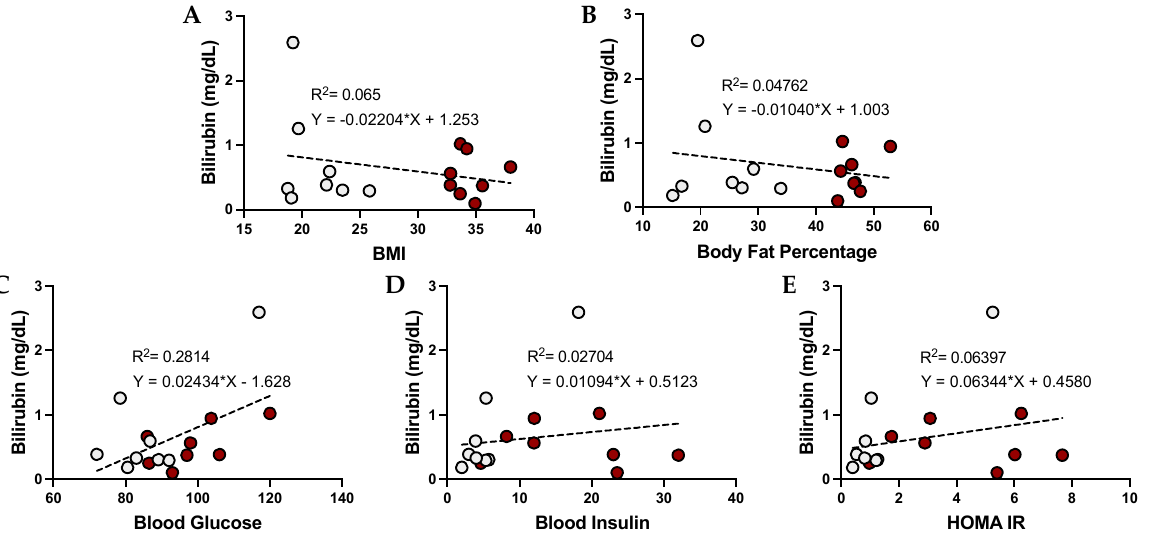
Figure 6. Bilirubin levels and correlations with metabolic phenotypes in women . Comparisons of metabolic phenotypes in women with plasma bilirubin levels for ( A ) BMI, ( B ) body fat percentage, ( C ) blood glucose, ( D ) blood insulin, and ( E ) HOMA IR. The data were plotted as dot plots, linear regression was calculated, and the slope of the line was used to determine the relationship and the robustness of the data. Red circles are for obese women, and gray circles are for their lean counterparts.